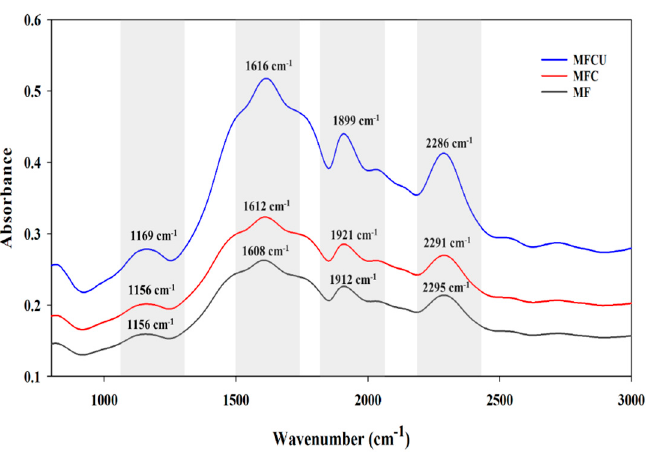
Figure 2. FTIR spectra of mung bean flour-based films processed under different conditions.